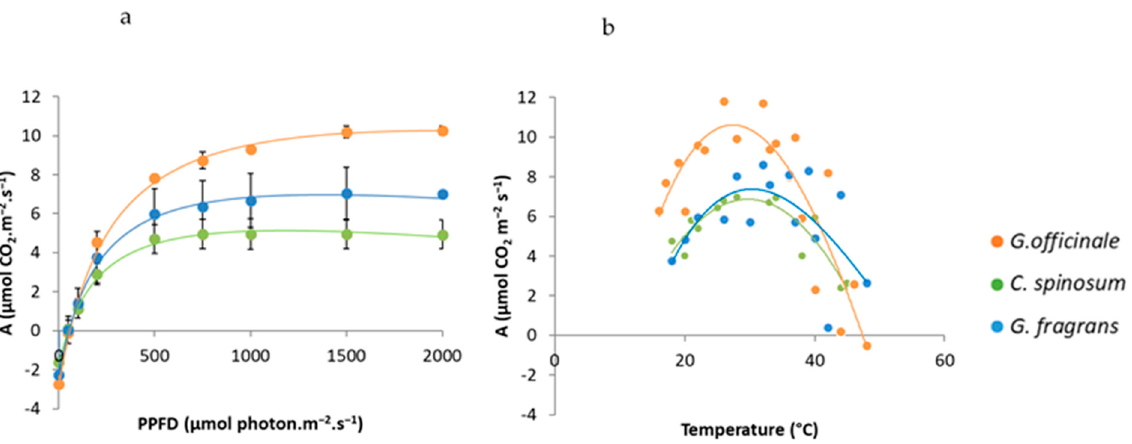
Figure 4. Photosynthetic response curves to light ( a ) and temperature ( b ); n = 4 for each curve; bars represent SE.